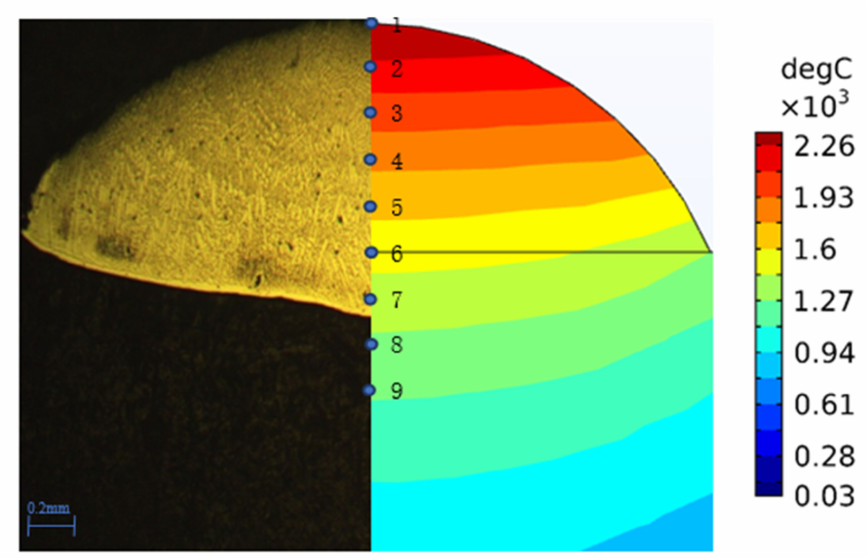
Figure 11. Experimental and simulation results.